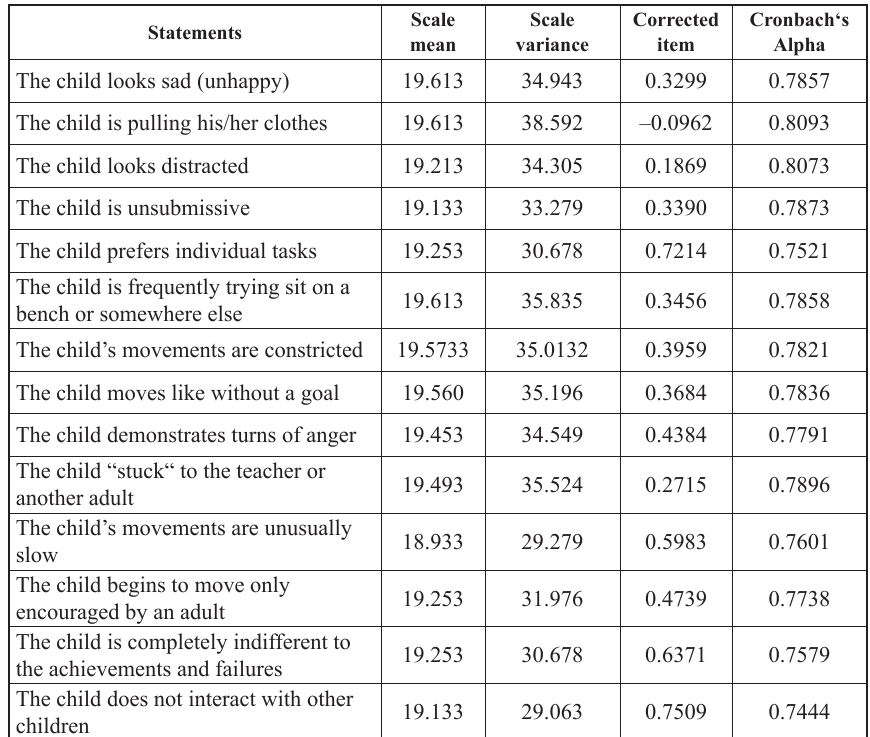
Table 1. The internal consistency of the